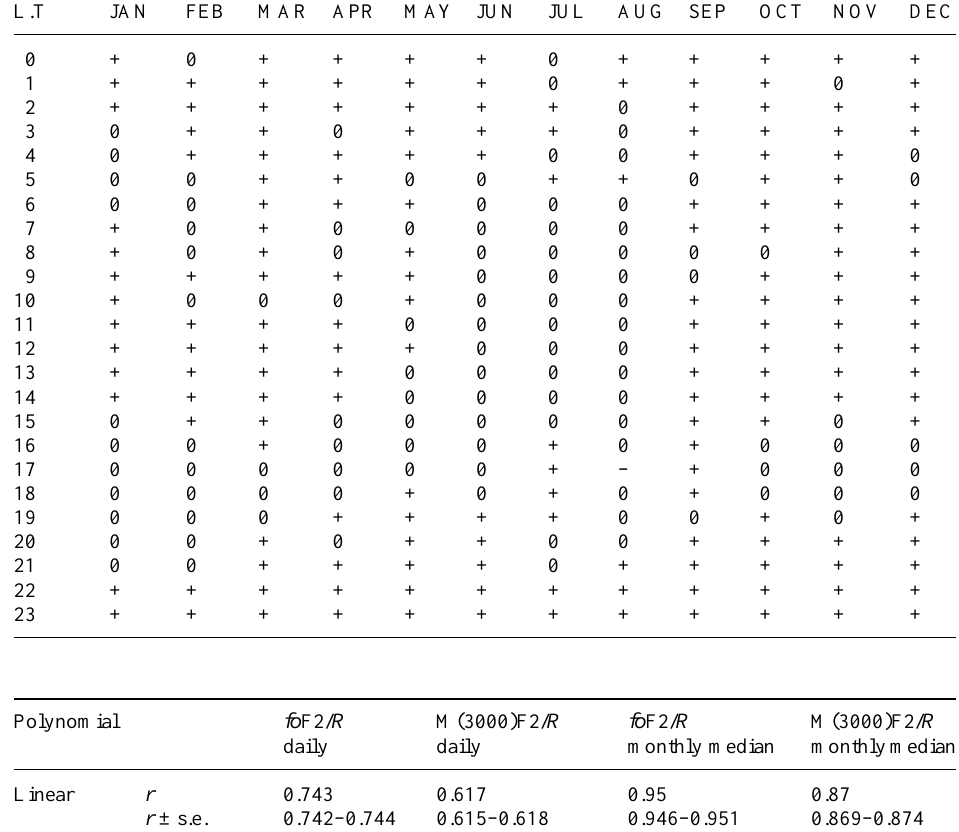
Table 4. Averaged combined correlation coefficients and their standard errors over all station-time data sets given by daily and monthly median analyses when different poly- nomial orders are adopted